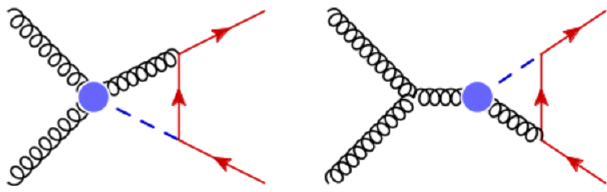
Figure 4 . One-loop matching to compute C HG .